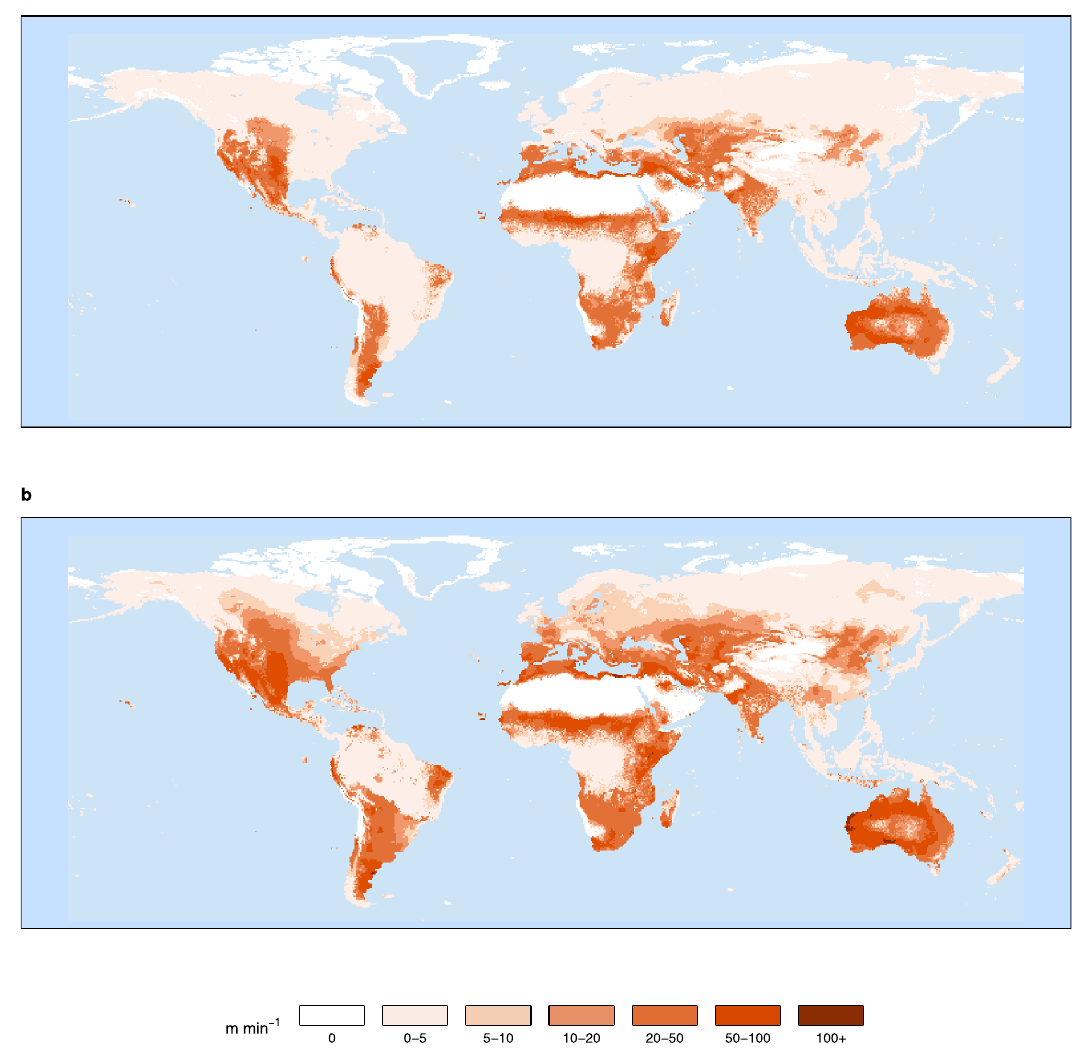
Fig.3| Global fi rerateofspread. Takenasa10-yearannualaveragefromthelastdecadeof LPJ-LM fi refor a present-daylevelof atmosphericoxygen(20.95%)and b 35% vol. O 2